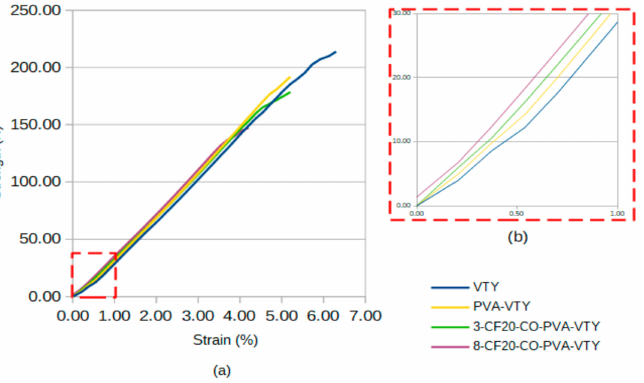
Figure 8. Line chart representing the strength as a function of the strain for each step allowing the realisation of sensor yarns ( a ) with a zoom on the first percentage of deformation ( b ).